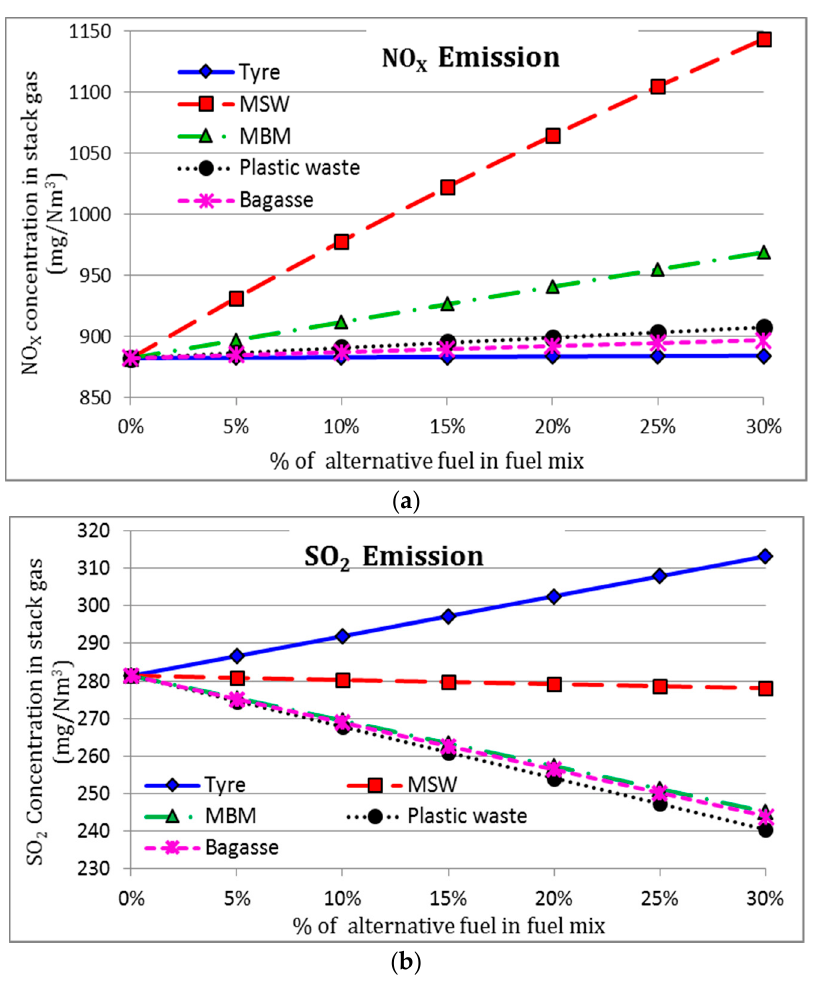
Figure 5. ( a ) NO X concentration and ( b ) SO 2 concentration in stack gas (mg/Nm 3 ).